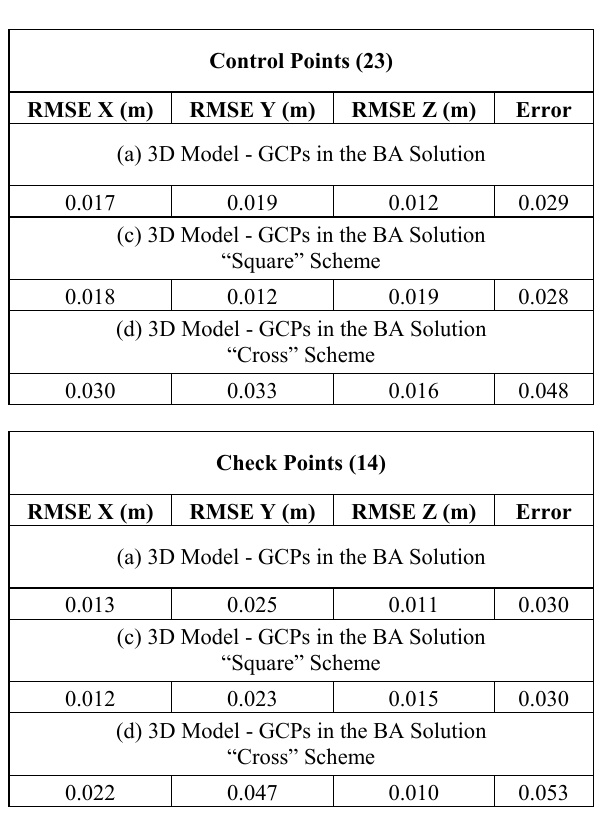
Table 2. A comparison between the 3D models created: RMS error of the GCPs (on the top) and Check points